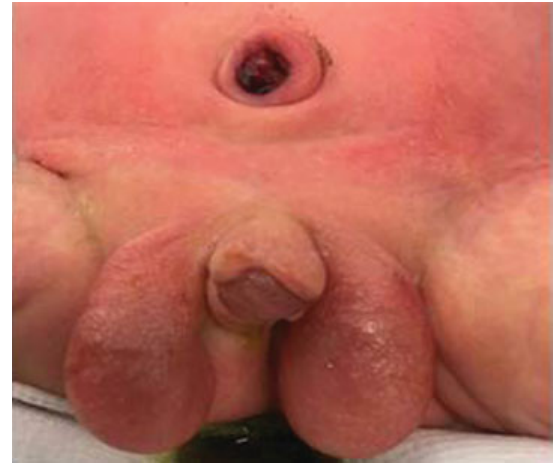
Fig. 1 Male newborn with clinical features of covered cloacal exstrophy: pubic bone diastasis, lowlyingumbilicus, and meconium in urine (rectourinary tract fi stula).